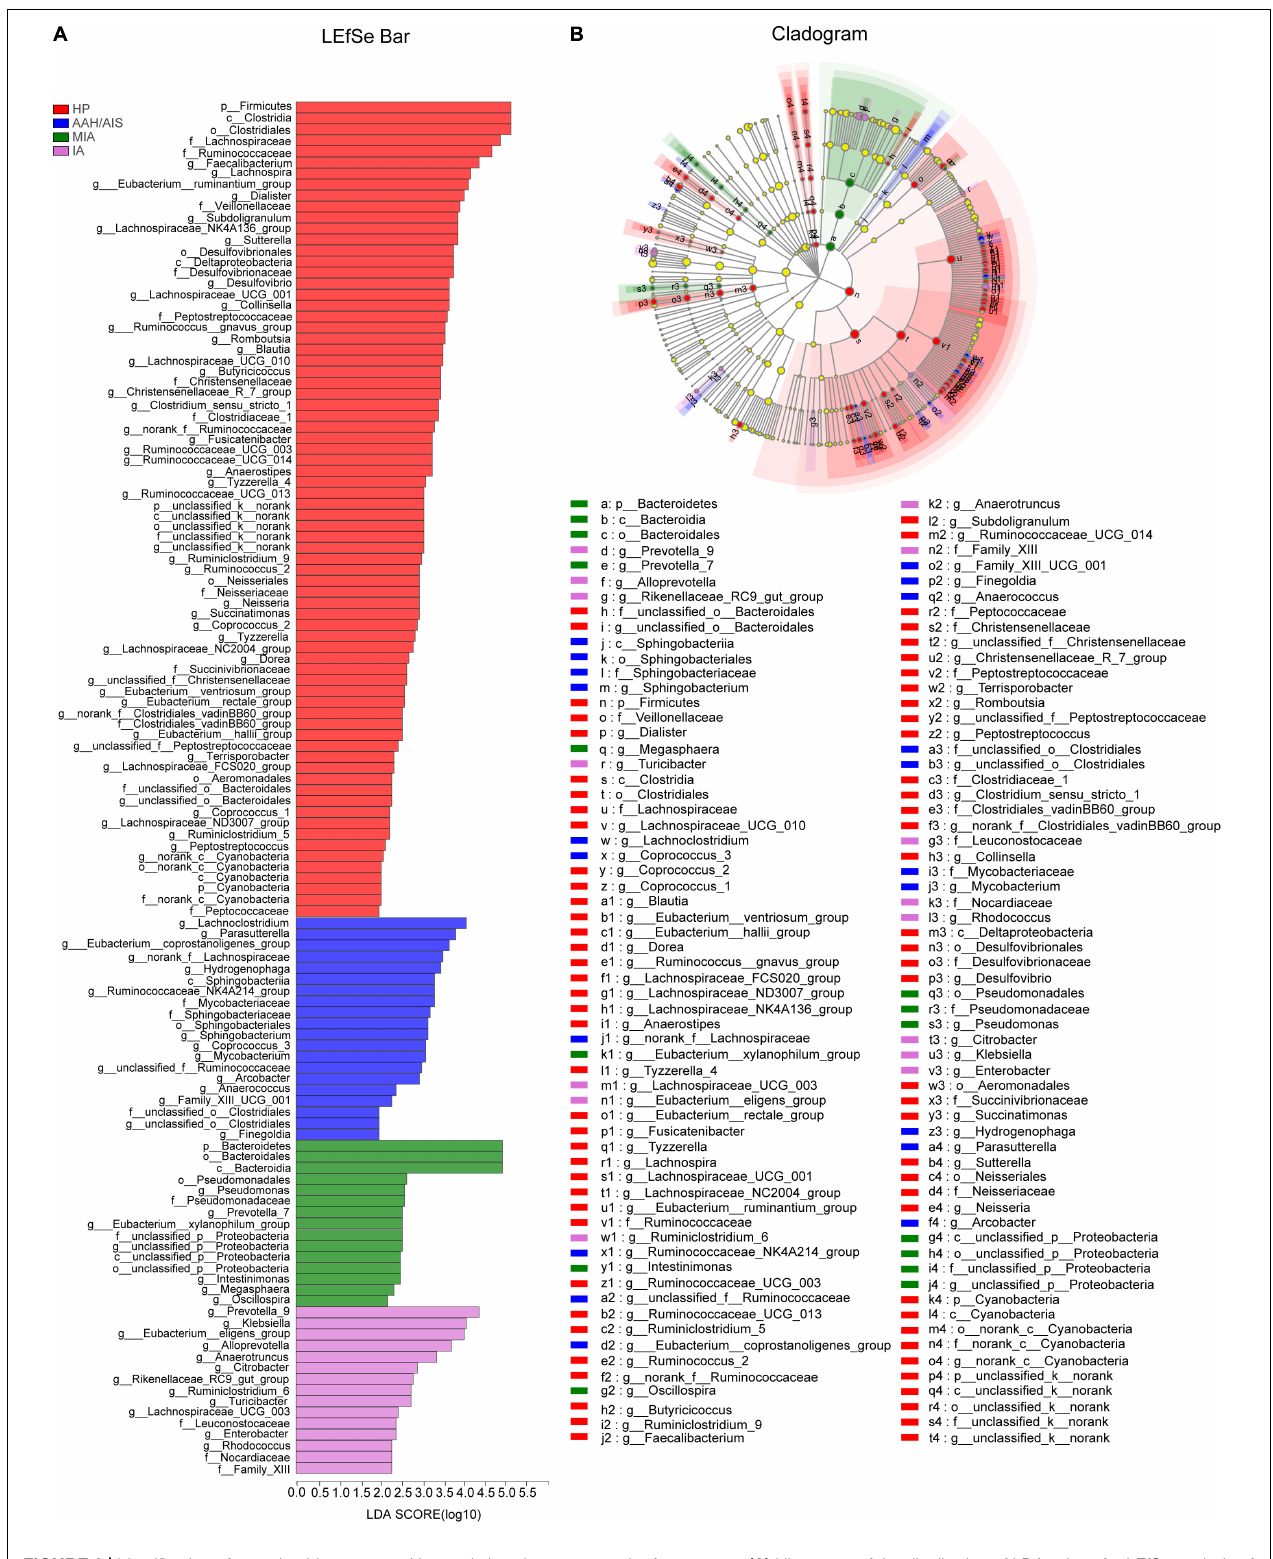
FIGURE 6 | Identification of gut microbiota composition and abundance across the four groups. (A) Histogram of the distribution of LDA values for LEfSe analysis of intestinal flora in four groups of samples. (B) Evolutionary map of species branching for LefSe analysis of intestinal flora in four groups of samples.